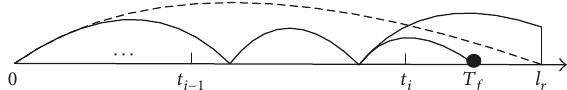
Figure 10: A postponed inspection replacement before which the minor defective stage is not